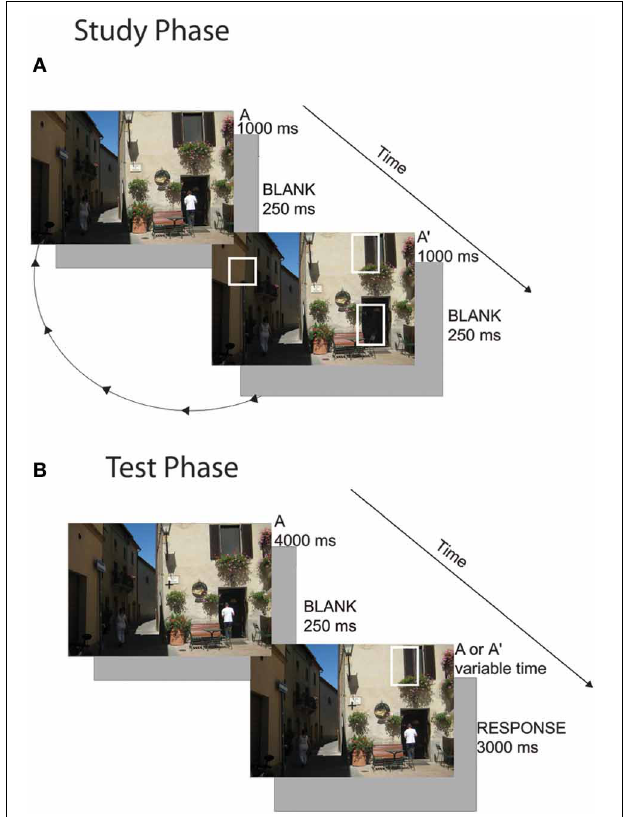
FIGURE 1 | Change detection task. (A) Cycling Study Phase: during the study phase, subjects freely viewed images in a flicker paradigm. They were instructed to click on the changes as they found them. In Experiment 1, subjects viewed 80 scenes with 0, 1, 2, or 3 changes. In Experiment 2, subjects viewed 20 scenes with 3 changes and studied the set three times. (B) One-shot Test Phase: subjects held central fixation while a novel or familiar scene image appeared. They were instructed to covertly attend to where they thought a change might occur. The image disappeared and then flashed briefly with 0 or 1 change and then disappeared again. The subject had to determine whether a change